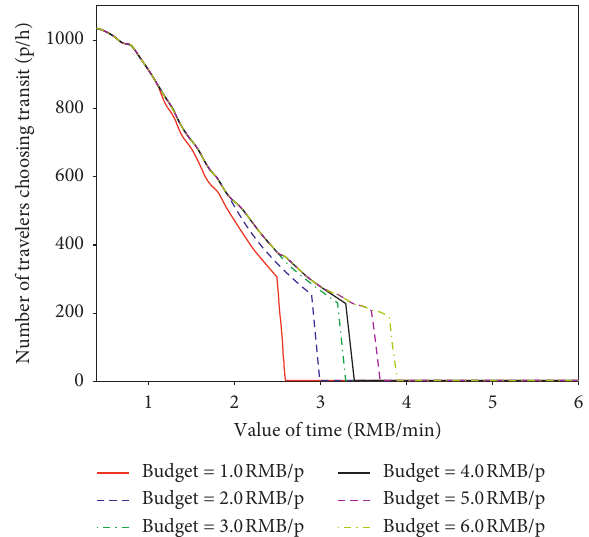
Figure 7: Variation of transit users with VOT under different budget levels.